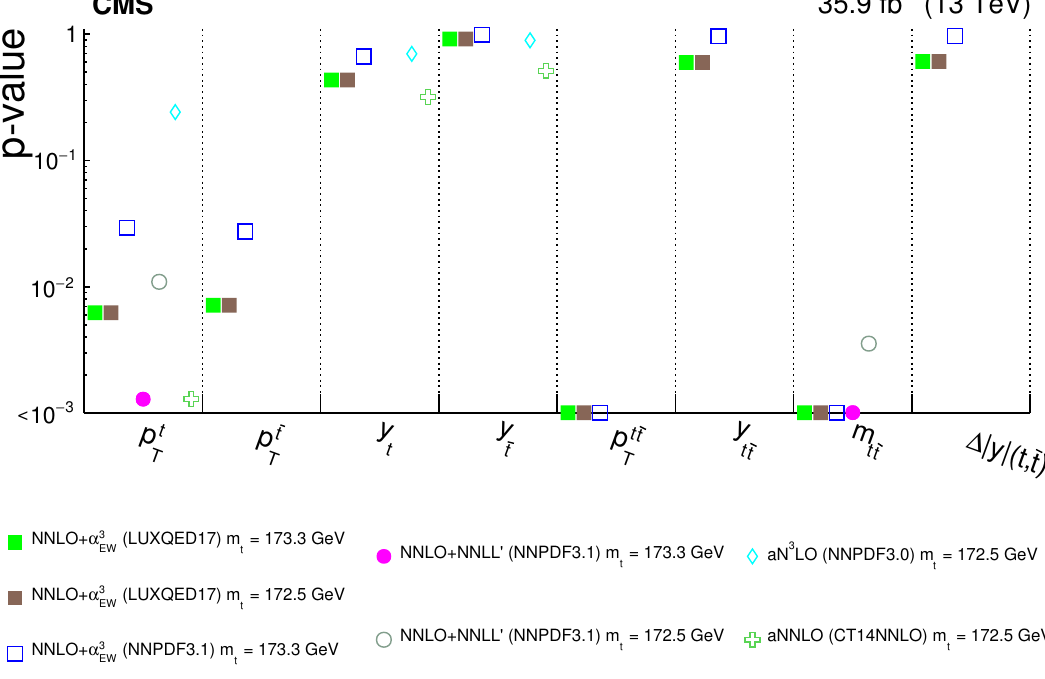
Figure 53 . The p -values quantifying the agreement between theoretical predictions with beyond- NLO precision and the data for selected normalised measurements at parton level are shown. Points situated on the horizontal axis indicate p -values of less than